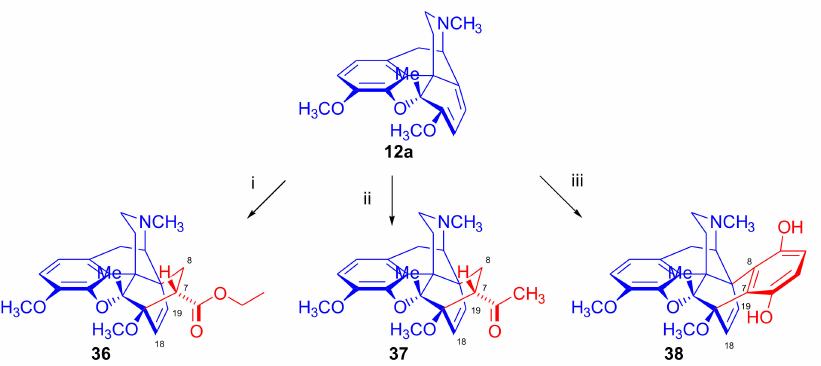
Figure 13. Cycloaddition reactions of 5 β -methylthebaine. Reagents and conditions : (i): ethyl acrylate, reflux, 96 h, (ii): methyl vinyl ketone, reflux, 48 h, and (iii): p -benzoquinone, toluene, 90–100 ◦ C, 24 h.